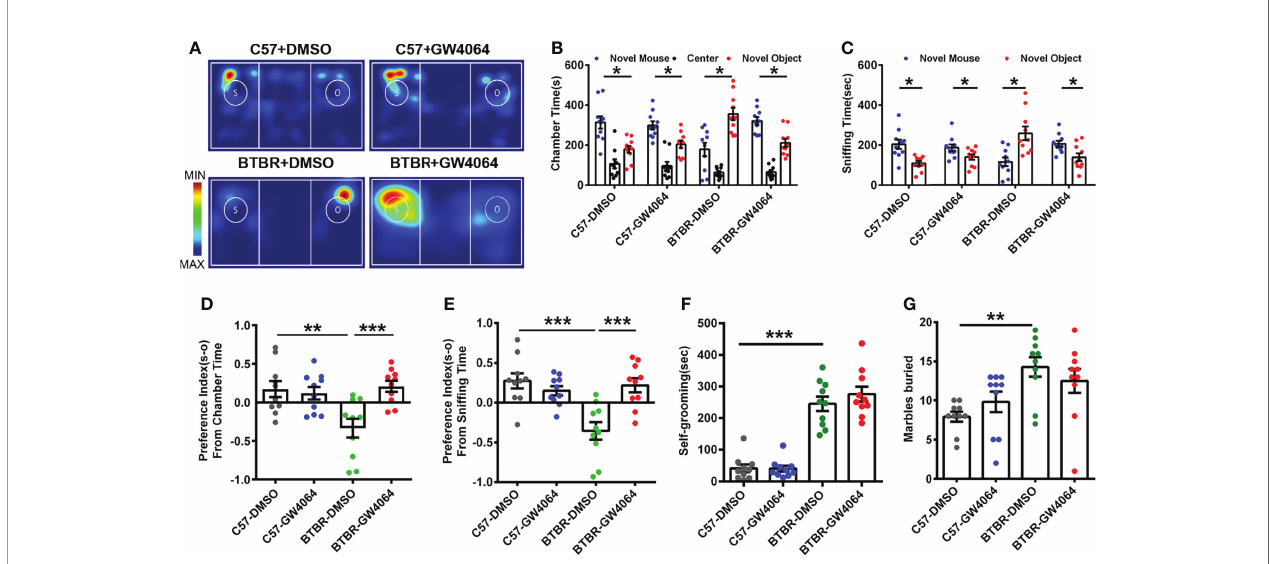
FIGURE 1 | GW4064 treatment rescued the social de fi cits but not repetitive behaviors in BTBR mice. (A) Representative heat maps showing the total time and location of the BTBR and C57 mice during the 10 minute three-chambered social test. The closer the color is to red, the larger amount of time they explore the mice. “ O ” and “ S ” respectively represent the novel object and the novel mouse. (B) In the three-chamber test, C57 mice stayed longer in the side chamber than the novel mouse, GW4064 or DMSO administration did not affect the sociability in C57 mice. BTBR mice displayed a tendency to spend more time in the side chamber with the novel object. GW4064 treatment rescued the social de fi cits in BTBR mice. (C) In the three-chamber test, C57 mice spent more time snif fi ng the novel mouse. BTBR mice sniffed more on the novel object, while GW4064 treatment signi fi cantly rescued the social de fi cits in BTBR mice. (D, E) The treatment of GW4064 reversed the negative preference index from chamber time and snif fi ng time in BTBR mice to a similar level in C57 mice. (F, G) BTBR displayed a higher self-grooming time and buried more marbles than C57 mice, and the GW4064 treatment did not alter the self-grooming time and marble burying in BTBR mice. The data are presented as the mean ± SEM. n = 10. *p < 0.05, **p < 0.01, ***p <